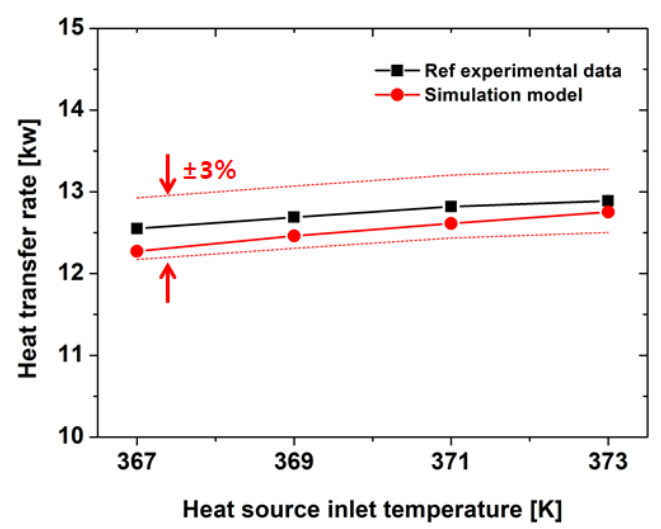
Figure 5. Validation of heat exchanger performance.